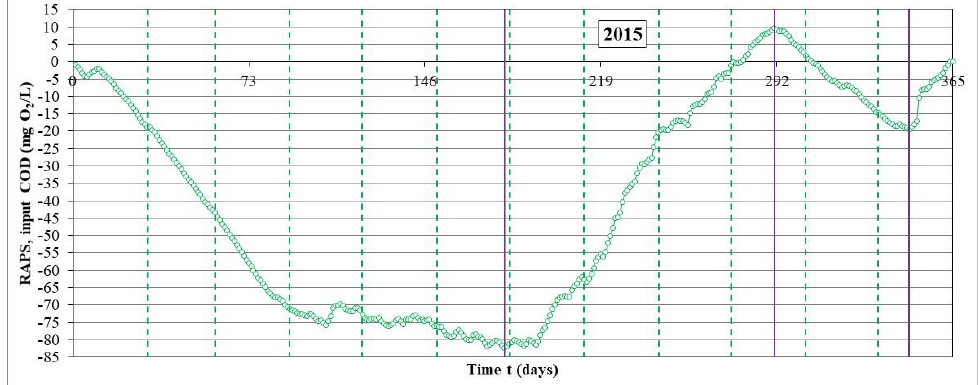
Figure 2. Input of COD for year 2015.